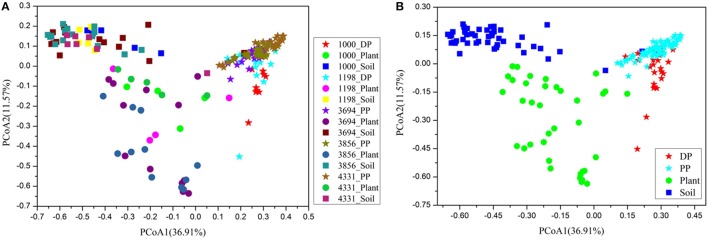
Principal coordinates analysis (PCoA) of pika, plant and soil bacterial communities across 185 samples based on the weighted UniFrac distance metrics. (A) 15 groups, including pika, plant, and soil bacteriome at five different altitudinal sites. (B) 4 groups, including DP (Daurian pikas), PP (Plateau pikas), plant and soil.